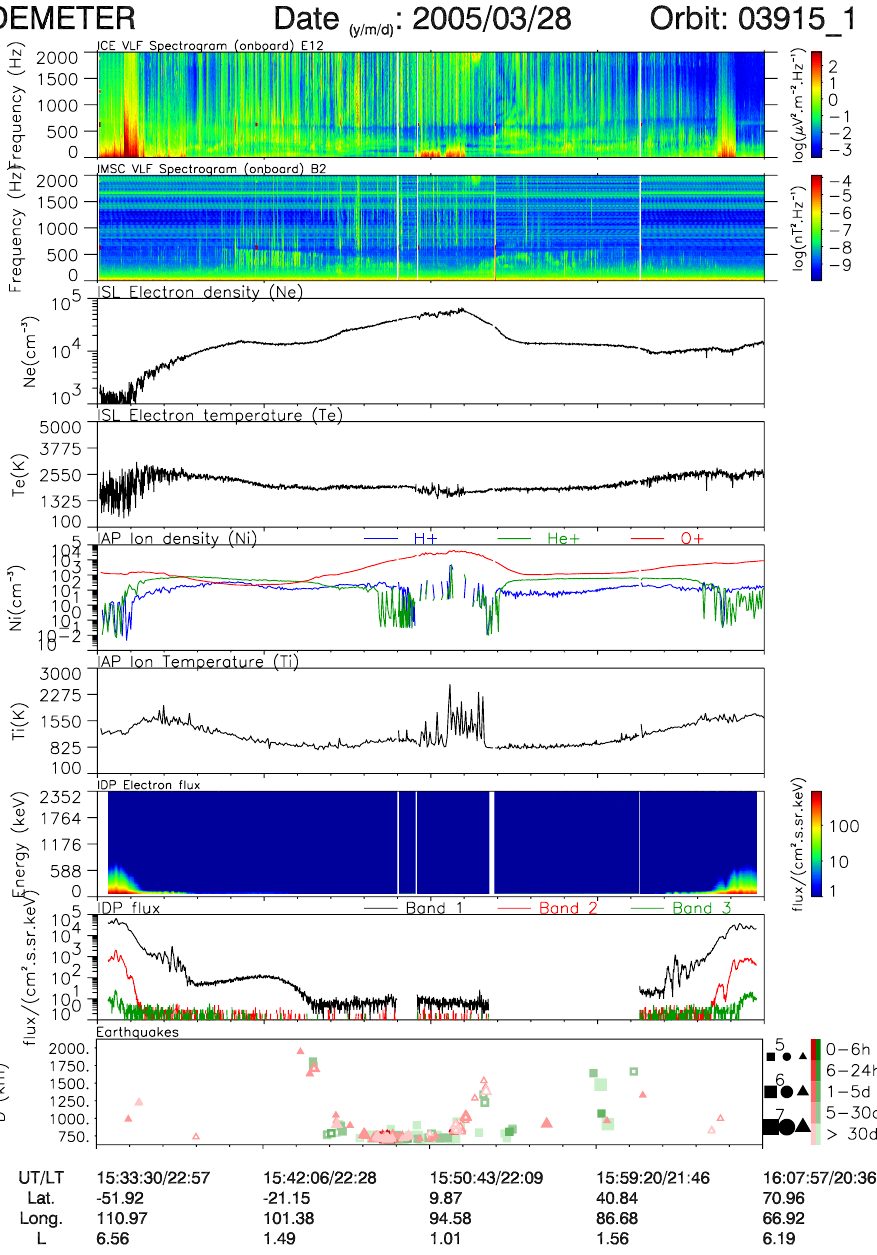
Fig. 1. The electromagnetic perturbations before the Sumatra 8.6 Earthquake on 28 March 2005.